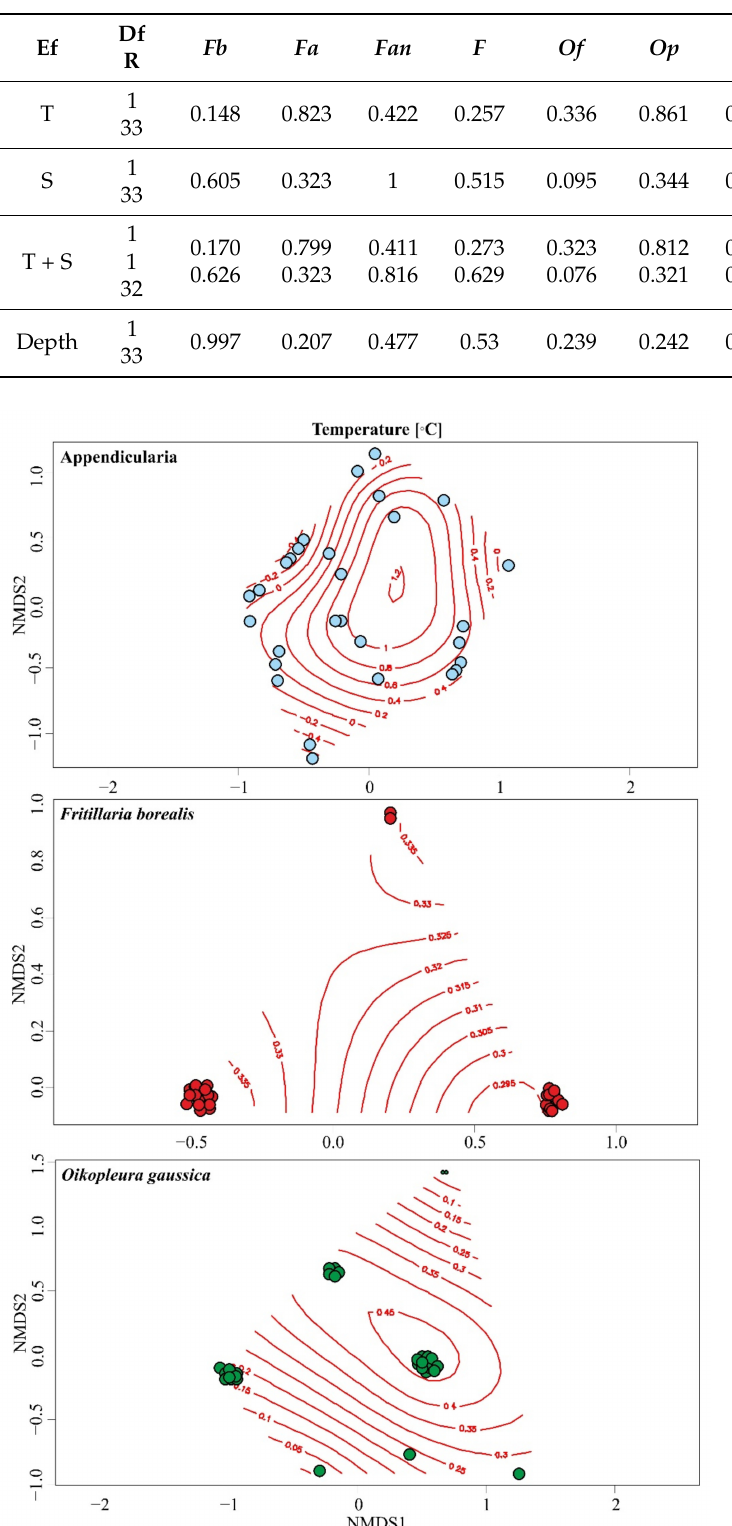
Figure 4. Ordisurf models showing the distribution of temperature over the NMDS clusters of Appendicularia (all identified species), Fritillaria borealis and Oikopleura gaussica . Circles represent samples and predicted temperatures for the community or selected species were plotted as a smooth surface on ordination